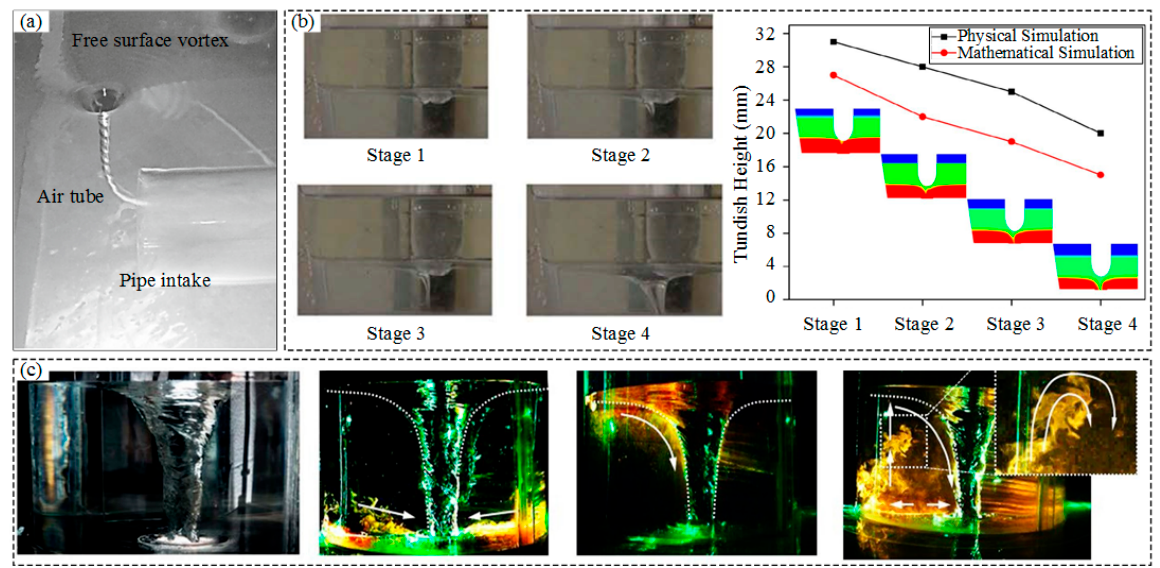
Figure 5. The evolution process of the gravitational surface. ( a ) Air-core vortex. (Reprinted with permission from Ref. [65]. 2018, Springer Nature). ( b ) Four stages of vortex formation. (Reprinted with permission from Ref. [66]. 2020, Springer Nature). ( c ) Steady vortex with a high Reynolds number. (Reprinted with permission from Ref. [67]. 2018, Springer Nature).